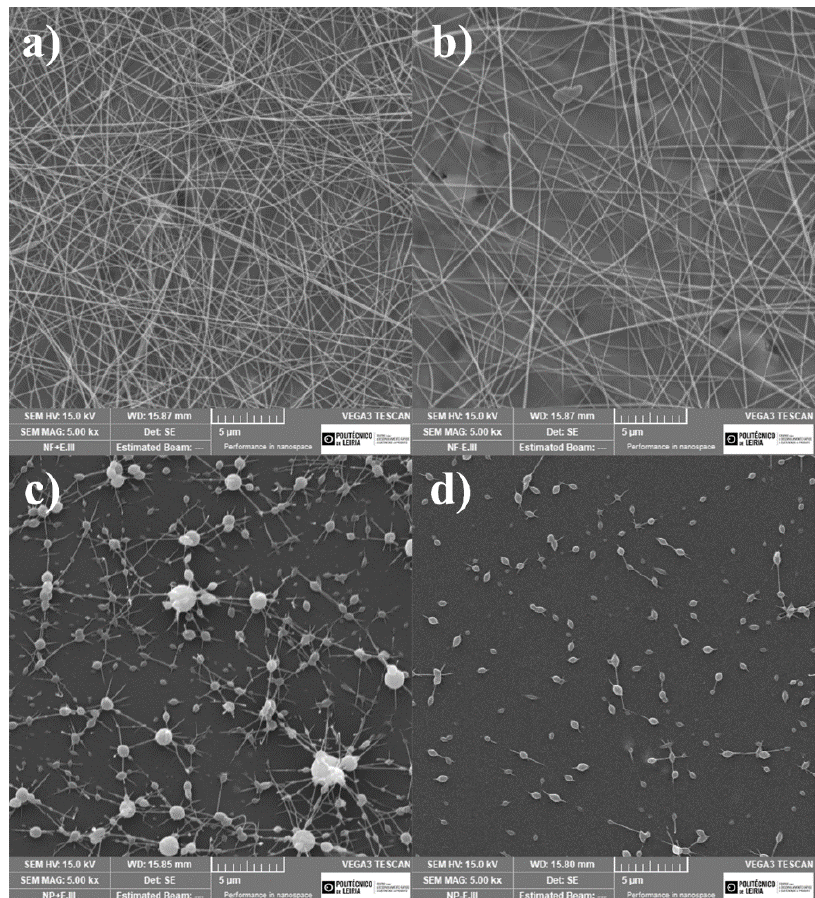
Figure 4. SEM images of the surface of ( a ) coating B (1 wt% P. dioica extract, 1 wt% PVA, 17 wt% gelatine), ( b ) coating B without extract ( 1 wt% PVA, 17 wt% gelatine), ( c ) coating A (5 wt% P. dioica extract and 7.5 wt% PVA), ( d ) coating A without extract (7.5 wt% PVA). All images were captured at 5000x amplification.